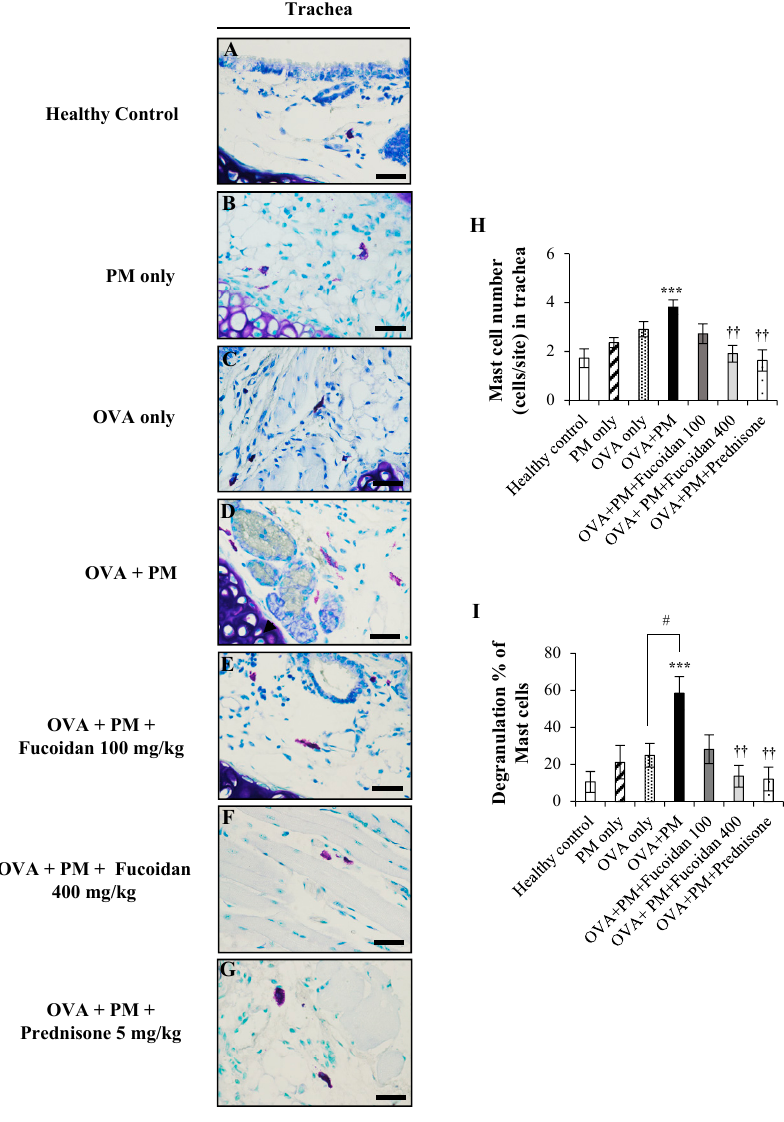
Figure 9. Toluidine blue staining of the trachea. ( A ) Healthy control, ( B ) PM only, ( C ) OVA only, ( D ) OVA + PM, ( E ) OVA + PM + Fucoidans (100 mg / Kg), ( F ) OVA + PM + Fucoidans (400 mg / Kg), ( G ) OVA + PM + Prednisone (5 mg / Kg). ( A – G ) Mast cell migration, ( H ) mast cell number per site, ( I ) mast cell degranulation percentage. Values are expressed as means ± SEM ( n = 3). *** ( p < 0.0005) represents a significant increase compared with the healthy control, and †† ( p < 0.005) represents a significant decrease compared with the OVA + PM group. # ( p < 0.05) represents a significant increase compared with the OVA only group. The scale bar of ( A – G ) is 25 µ